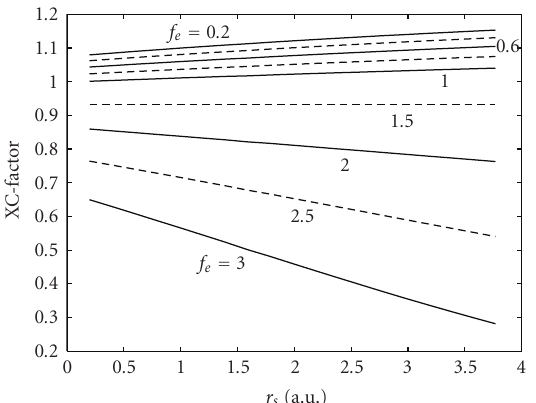
Figure 6: The calculated values of the scaling function X as function of r s and f e (see text). Table 2: The required applied magnetic fields (in mRy on Cu) in order to obtain a zero gap in LMTO calculations which include the di ff erent corrections to the potential; see the text.